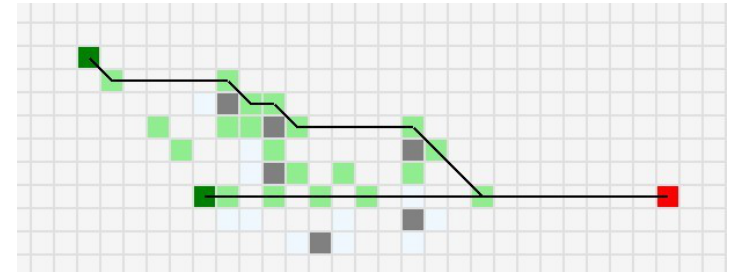
Figure 7. Modeling of Robot Envirionment in Grid Structure.